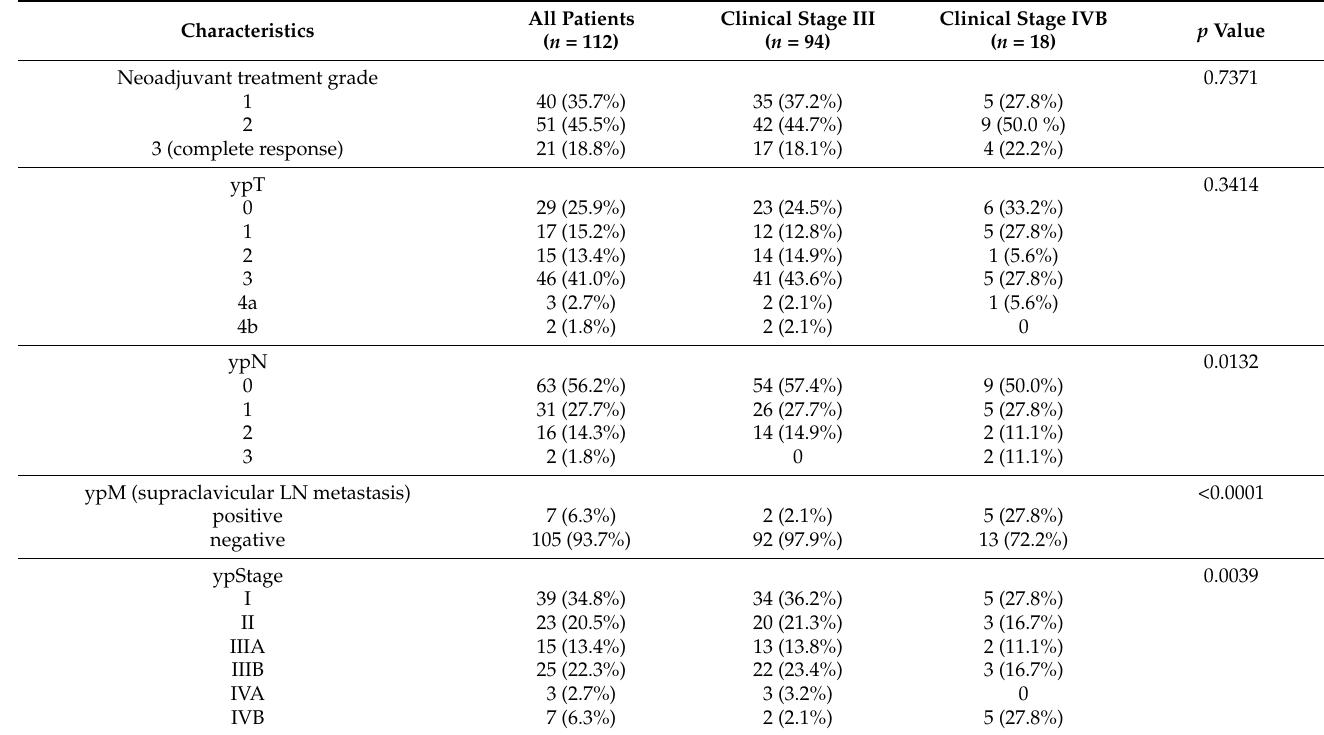
Table 2. Clinicopathological features of all 112 ESCC patients after neoadjuvant CRT.